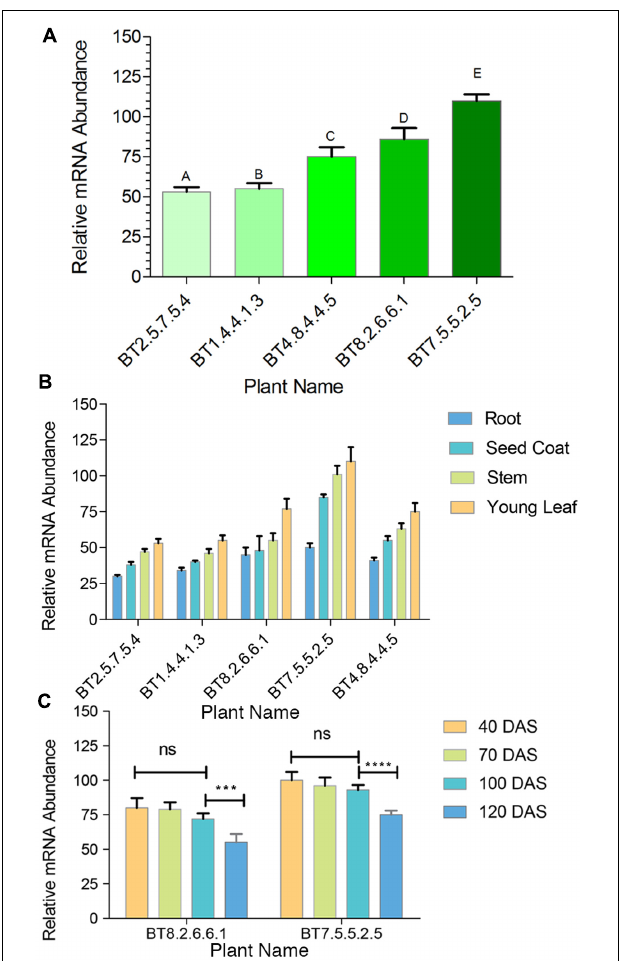
FIGURE 3 | qRT-PCR comparative analysis of mRNA transcript of transgenic plants. (A) Bar diagram showing significant difference among transgenic